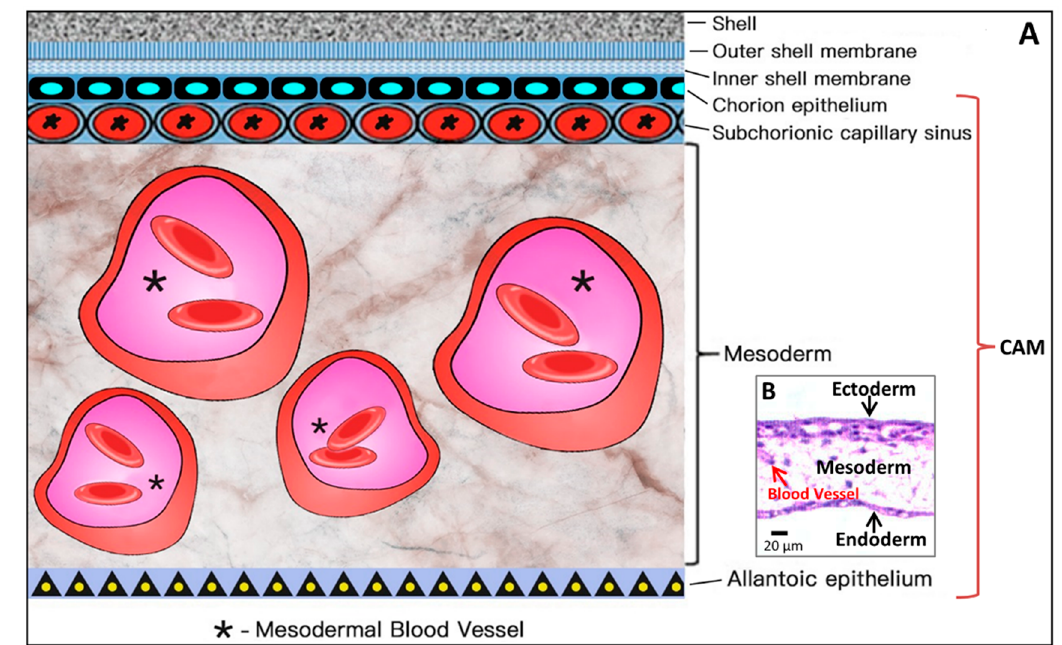
Figure 6. Simplified schematic diagram ( A ) showing the structural components of the CAM, which amplifies the embedded microscopic view of the haematoxylin-eosin-stained slice of the CAM ( B ) where the ectoderm includes the chorion epithelium and sub-chorionic capillary sinus layers of the CAM, and the endoderm corresponds to the allantoic epithelium of the CAM. *Larger vessels in the mesoderm (stroma).